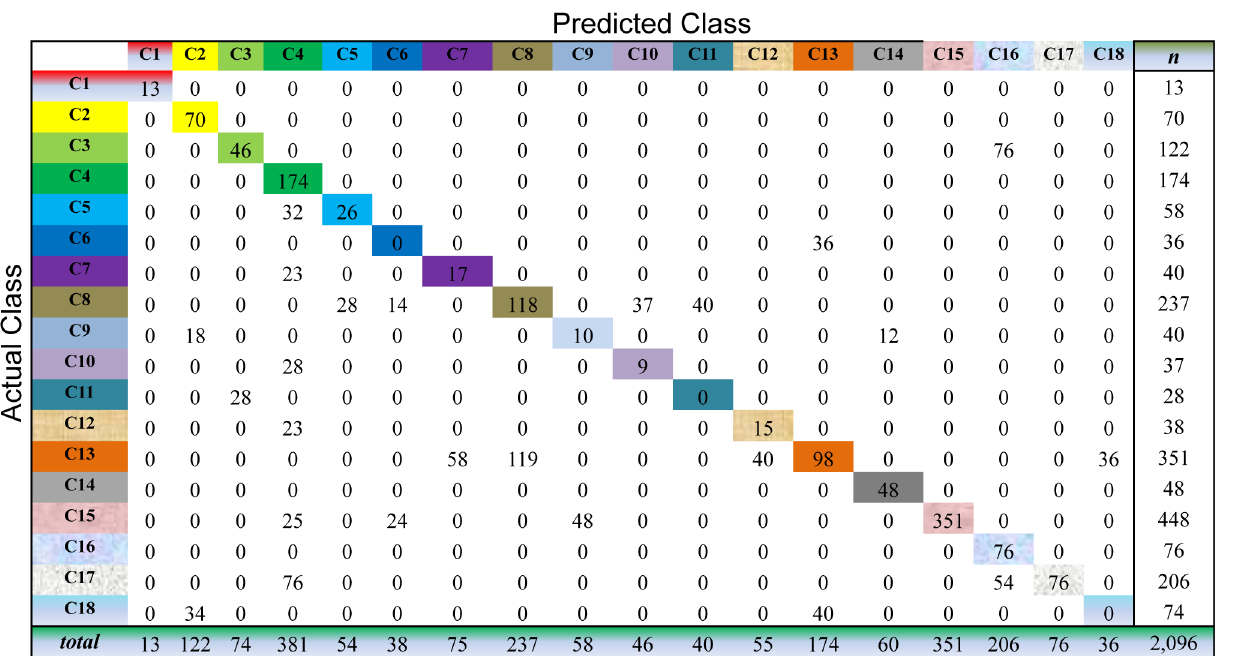
Fig 13. Confusion matrix of prediction results using TSVM, which achieves a total accuracy of 54.72%. Matrix delineates distribution of actual compared with predicted class membership for multiclass cancer prediction on the Acute Leukemia dataset.